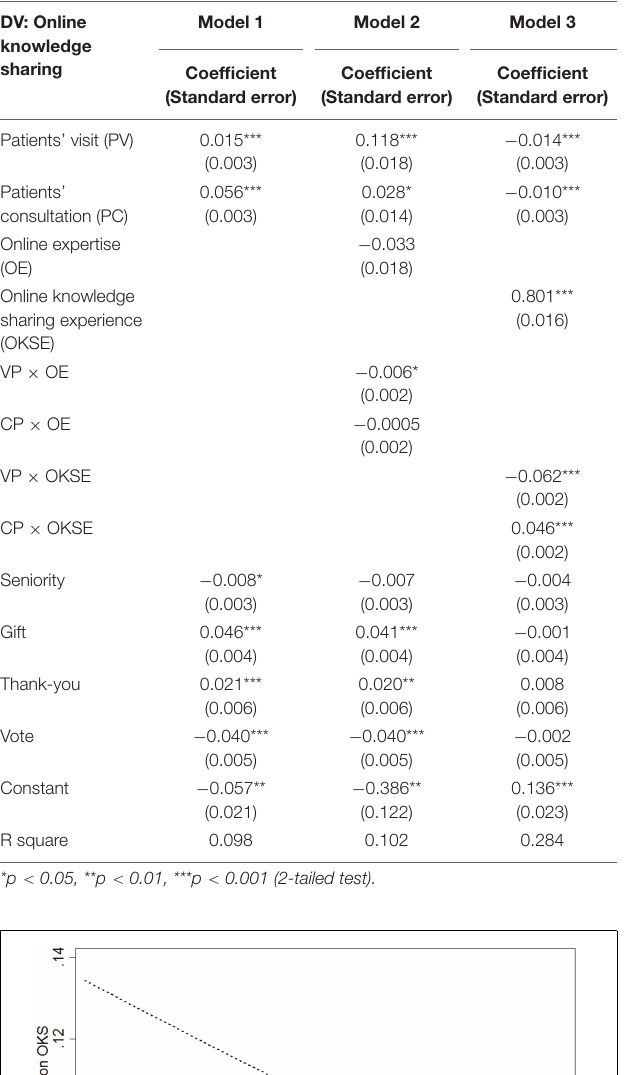
TABLE 3 | Results of hierarchical regression.